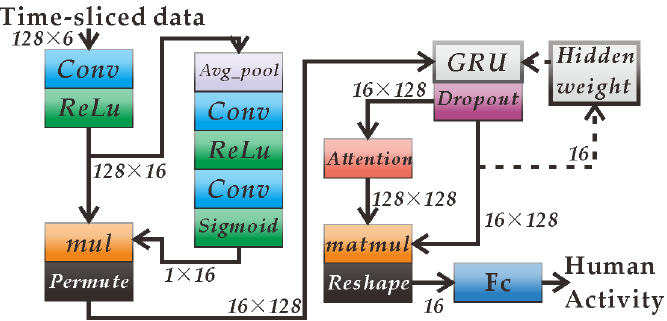
Figure 2. Logic structure of the proposed approach.